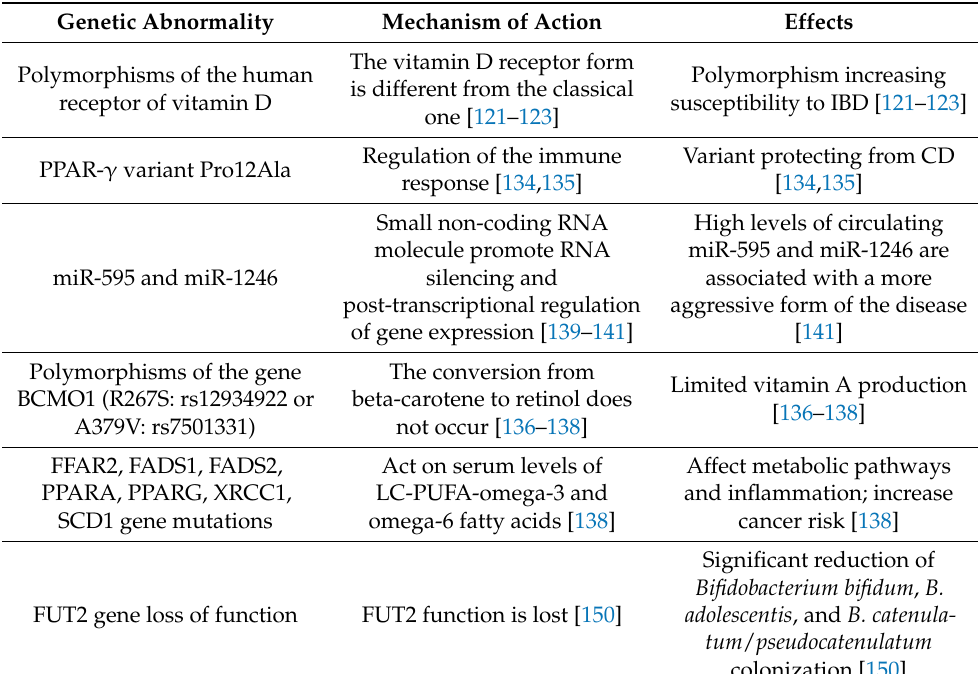
Table 4. Genetic abnormalities involved in the onset and/or outcomes of CD.